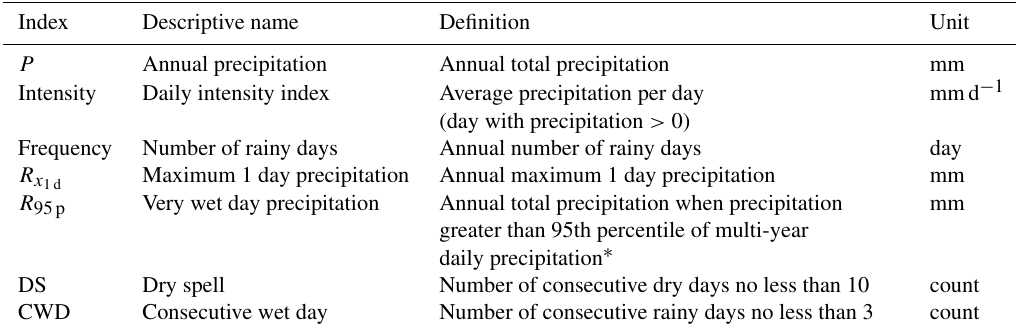
Table 1. Definitions of precipitation indices used in this study.